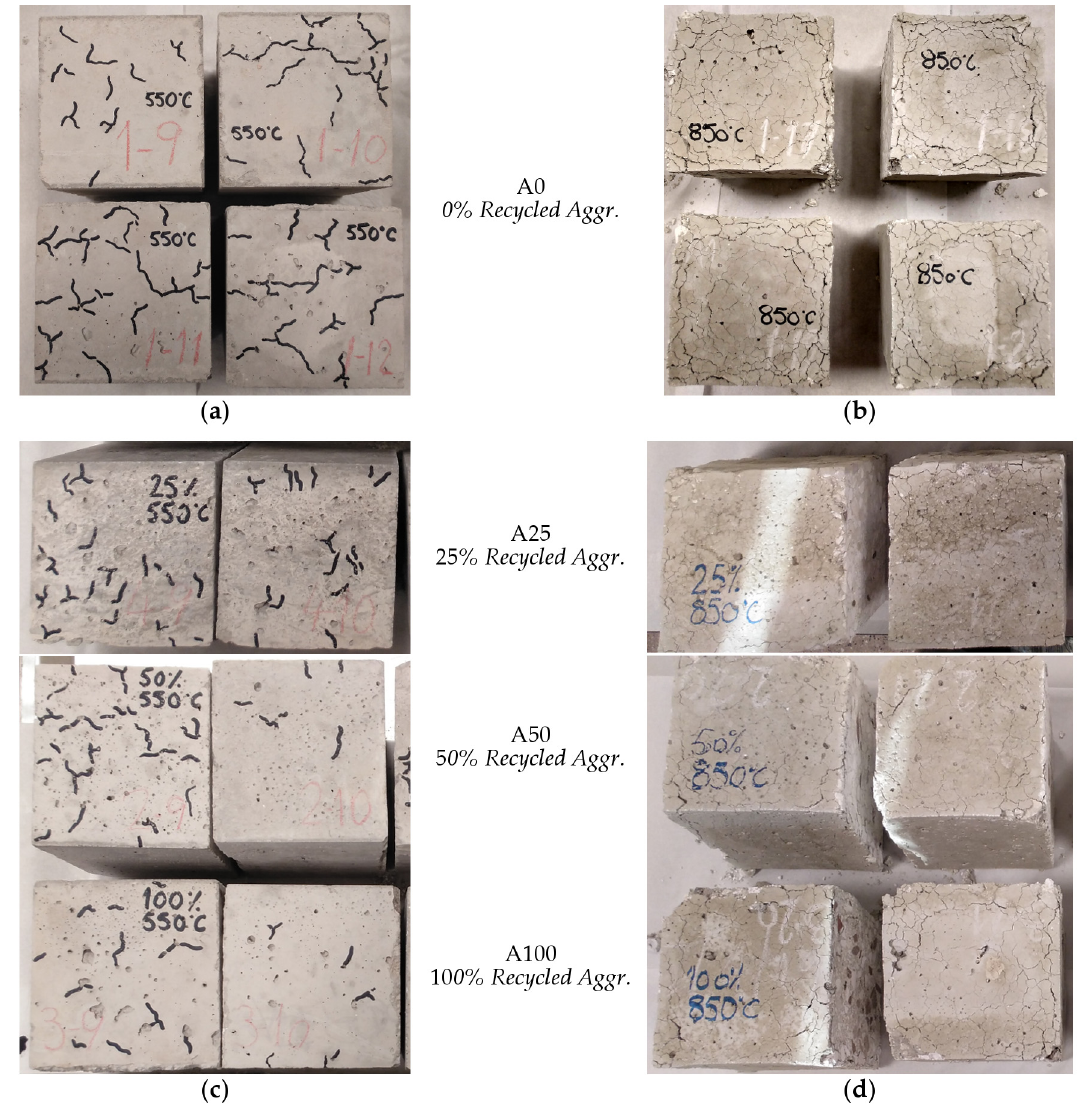
Figure 3. External cracking of specimens after high temperature exposure: NAC batches at ( a ) 550 °C and at ( b ) 850 °C; RAC batches at ( c ) 550 °C and at ( d ) 850 °C. Table 4. Evolution of the compressive strength at high temperatures.